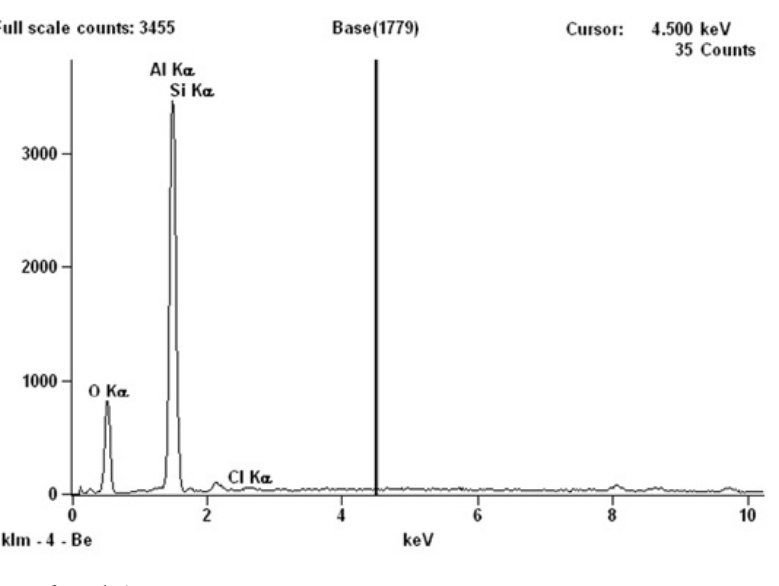
Figure 5. EDS spectrum of sample